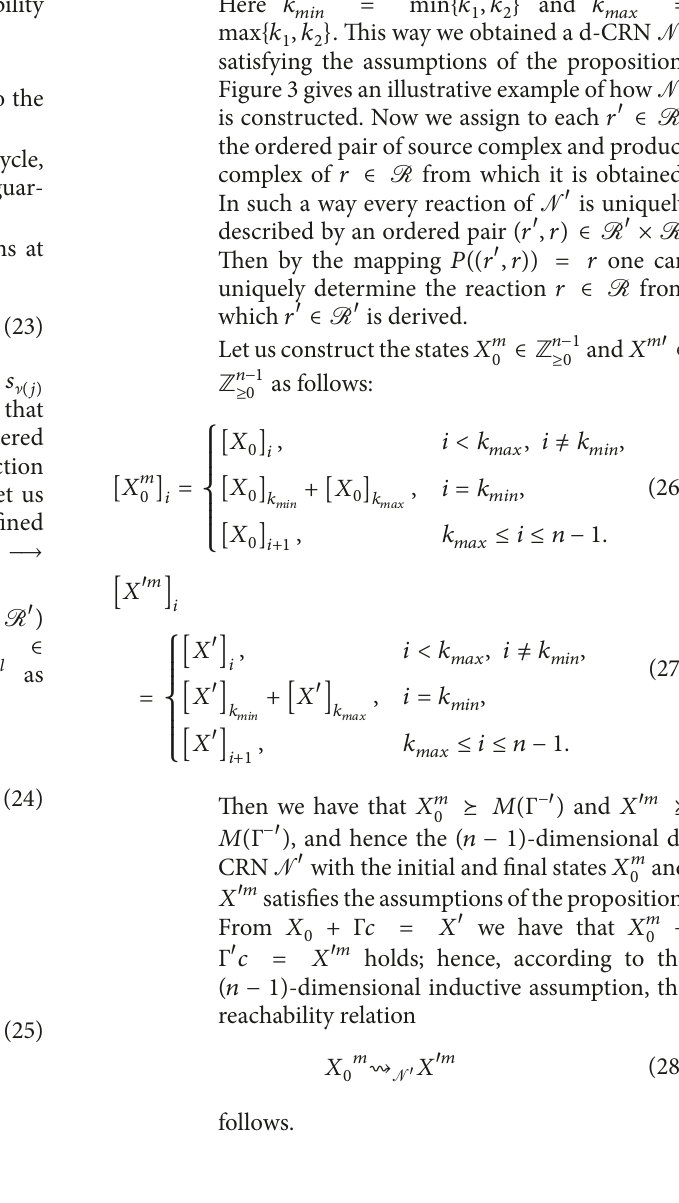
(and reverse counterpart reaction 𝑟 𝑘 ). Note that by merging 𝑠 𝑘 and 𝑠 𝑘 we obtain a stoichiometric matrix 1 𝑘 2 2 𝑘 1 1 2 , 𝑠 ) , (𝑠 ,𝑠 ) resulting in (𝑠 , 𝑠 󸀠 ) , (𝑠 ,𝑠 󸀠 ) ) and zero reaction vectors (i.e., self-loops on 𝑠 󸀠 1 𝑘 1 1 𝑘 2 1 1 𝑘 1 𝑘 1 lies is depicted in 1 𝑘 2